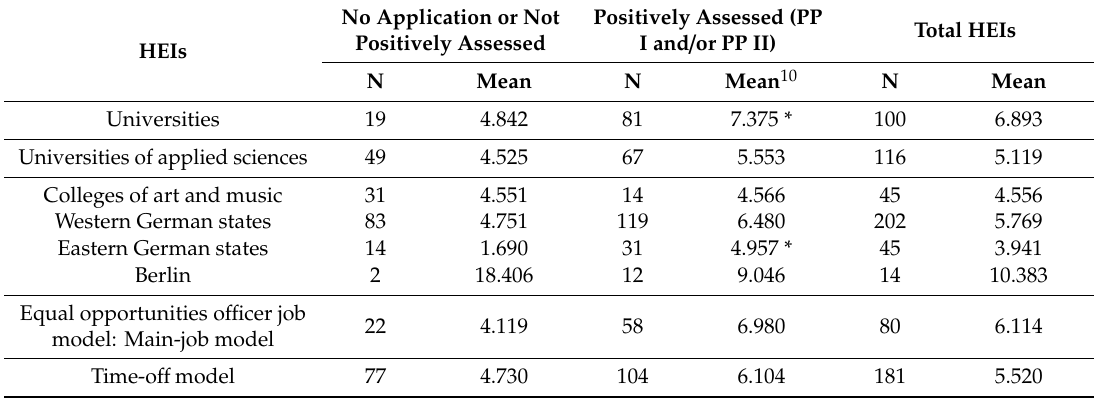
Table 4. Comparison of Means: Increase in the Proportion of Women Professors between 2007 and 2015 by participation in the Women Professors Program; Calculated Separately for Types of HEIs, Region, and Equal Opportunities O ffi cer Job Model.